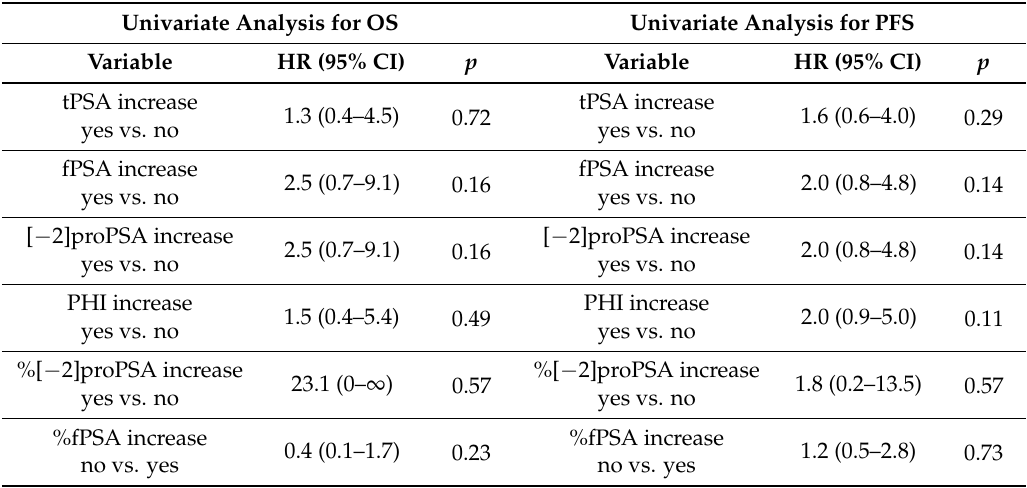
Table 3. Changes of median PSA-subform values in univariate analysis OS, overall survival; PFS, progression; HR, hazard ratio; CI, confidence